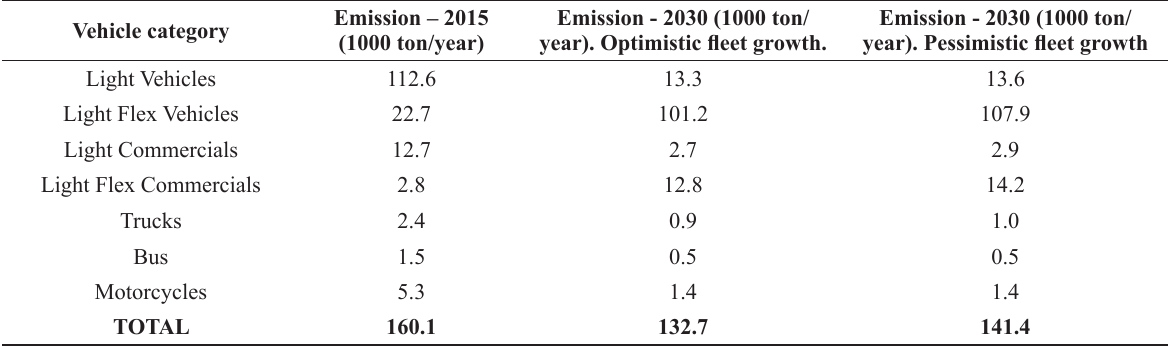
Total values of the CO emission, linked with the vehicular activity in the MRPA, according to the pessimistic and optimistic scenarios of the fleet for the years between 2015 and 2030.